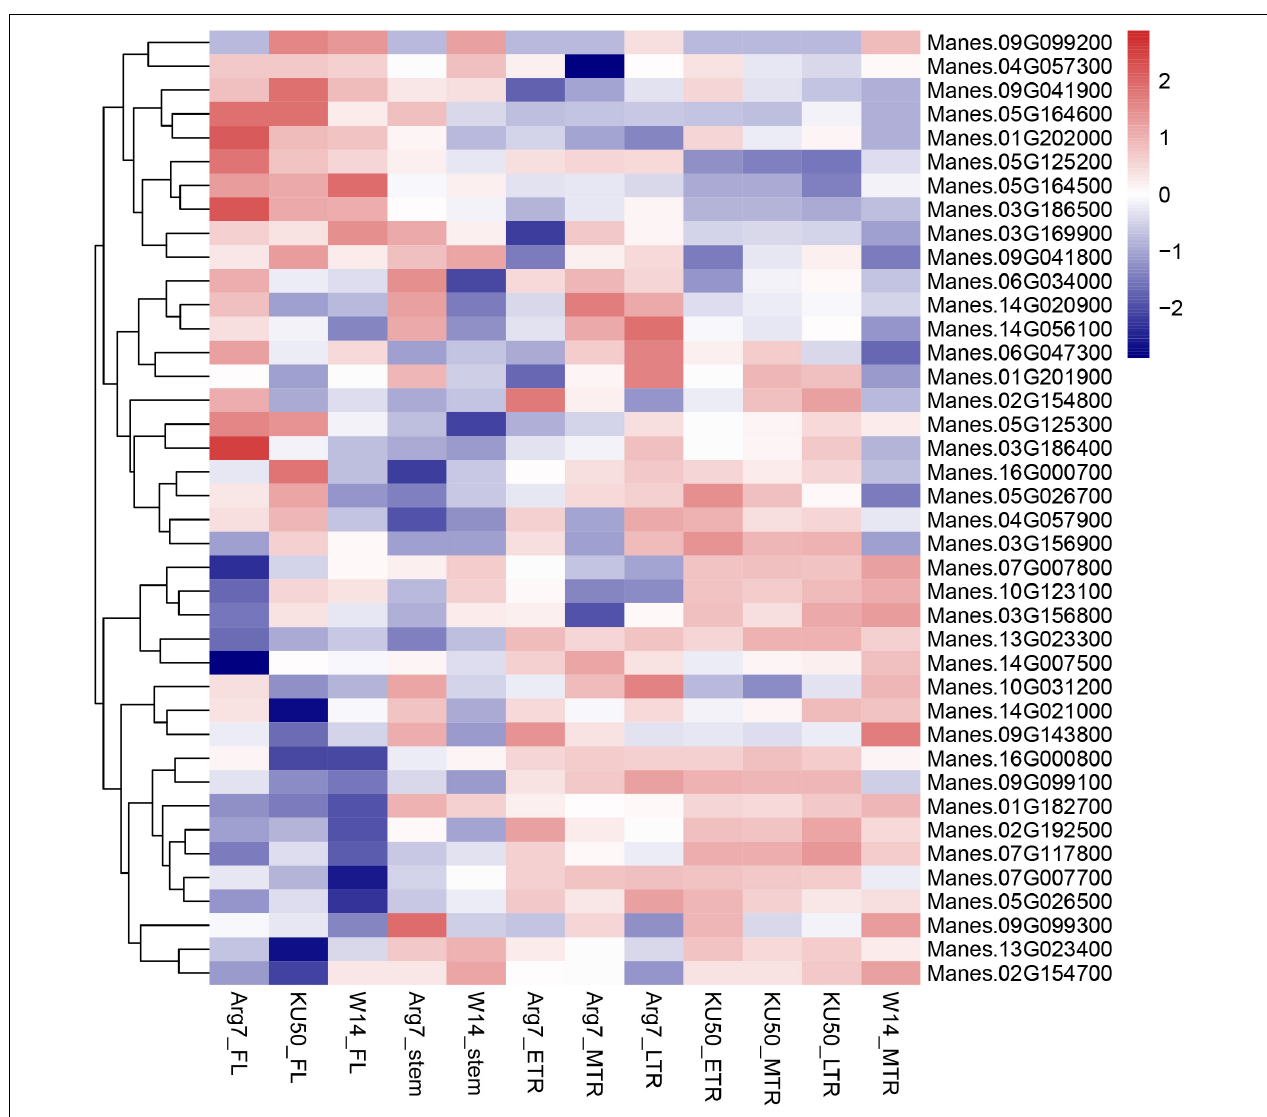
FIGURE 7 | Expression profiles of associated genes in cassava. A heatmap was drawn using log 10 -based FPKM-changed fold values. The differential expression thresholds of significant up- and downregulation were 3.0 and –3.0,